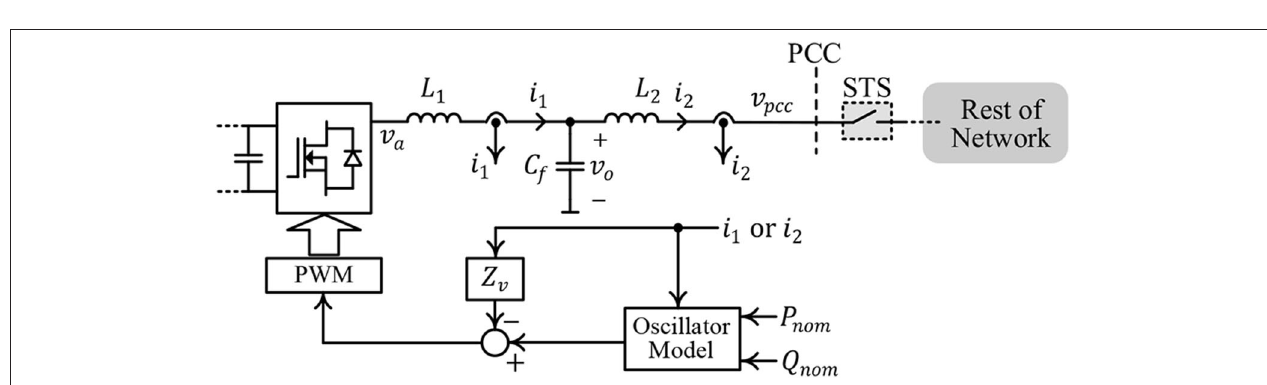
FIGURE 2 | GFM converter control structure using oscillator-based control without inner voltage and current control